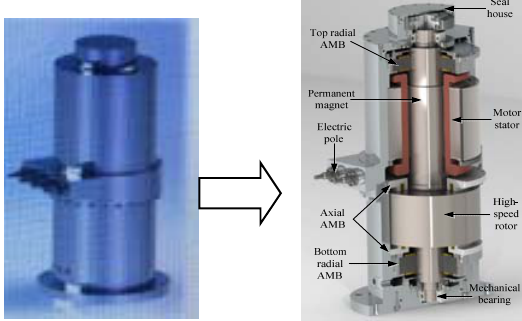
Figure 1. Schematic diagram of a magnetically suspended flywheel energy storage system (MSFESS).